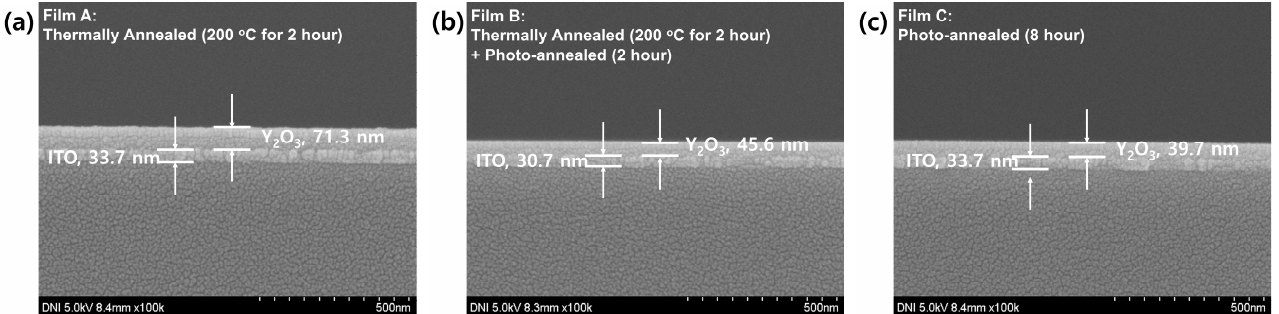
Figure 1. Cross-sectional scanning electron microscope images of Y 2 O 3 films obtained under different annealing treatments: ( a ) thermally annealed films, ( b ) thermally and photochemical annealed films, and ( c ) photochemical annealed films, respectively.